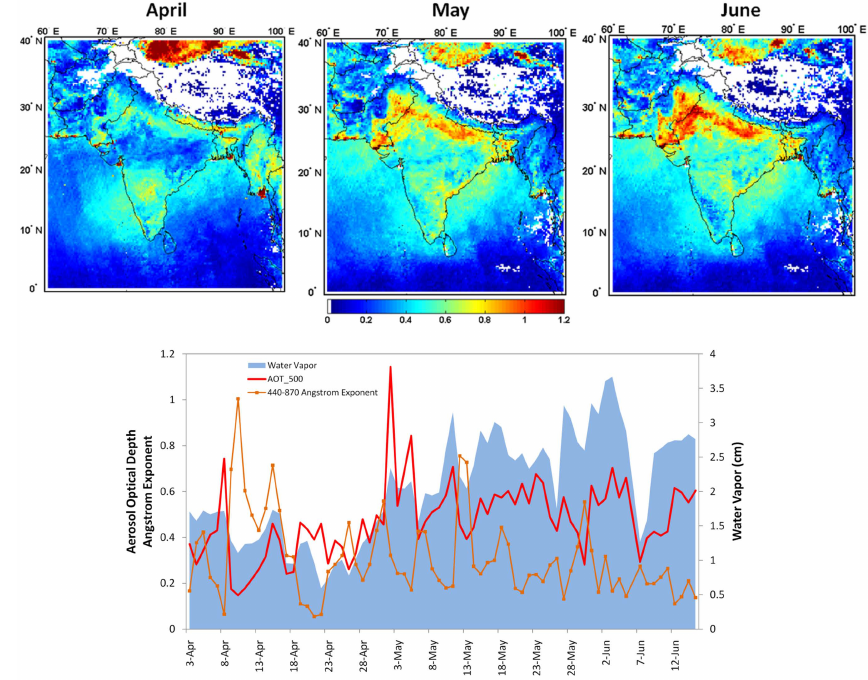
Fig. 3. (top panel) Monthly mean AOD for April, May and June 2009 obtained from daily Level-2 Aqua MODIS aerosol products showing the distribution of aerosol loading over the Indian subcontinent and the progressive increase in AOD over Northern India from April through June, with white shading representing no data (bottom panel). Daily mean variations of AOD at 500nm, AE for (440–870nm) and water vapor from CIMEL sunphotometer retrievals over Jaipur from 3 April to 15 June 2009. Monthly mean values during April, May and June for (1) AOD-0.36, 0.57 and 0.6; (2) AE-0.35, 0.31 and 0.19; and (3) WV-1.27, 2.43, 2.73cm,